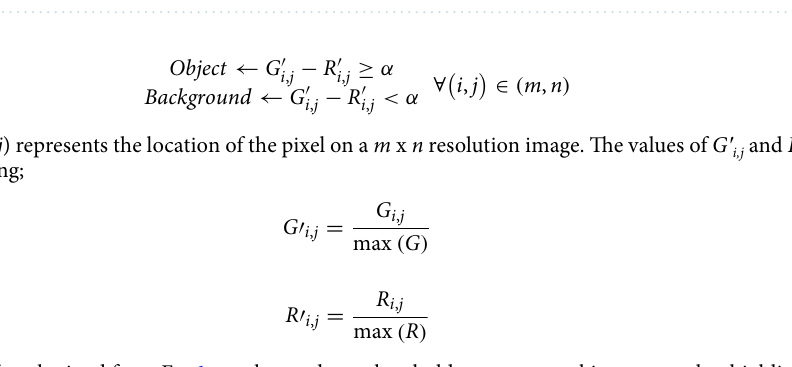
Figure 5. Pipeline for generating channel difference threshold label